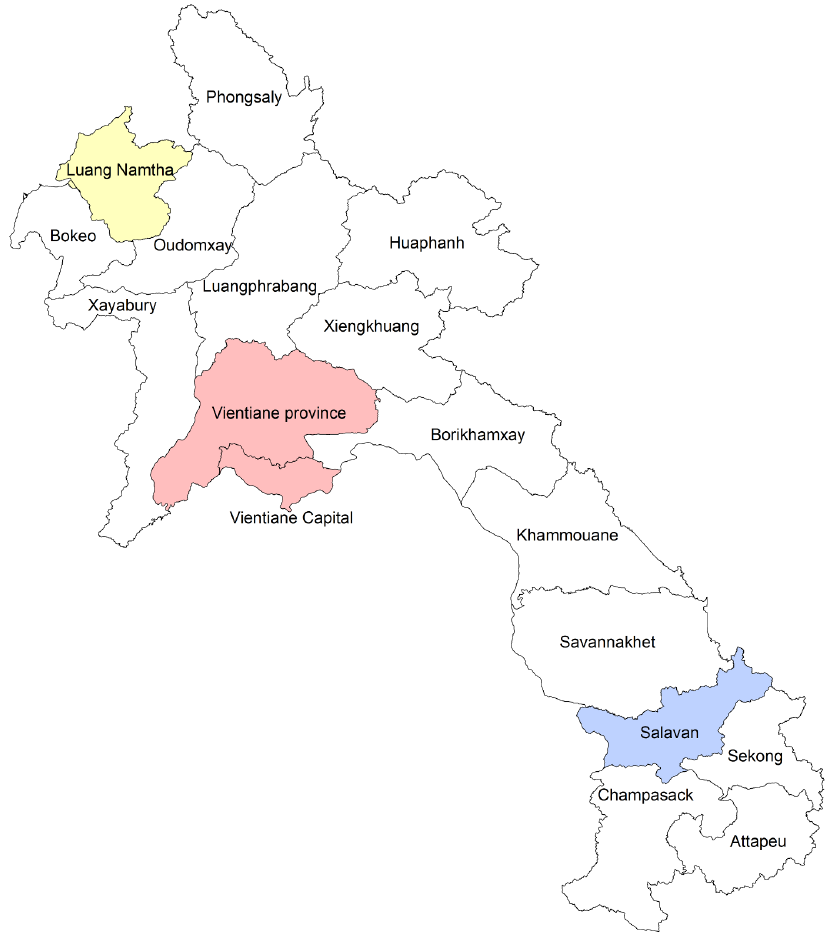
Fig 1. The geographic map of 3 study sites in Laos (Vientiane, Luang Namtha and Salavan).